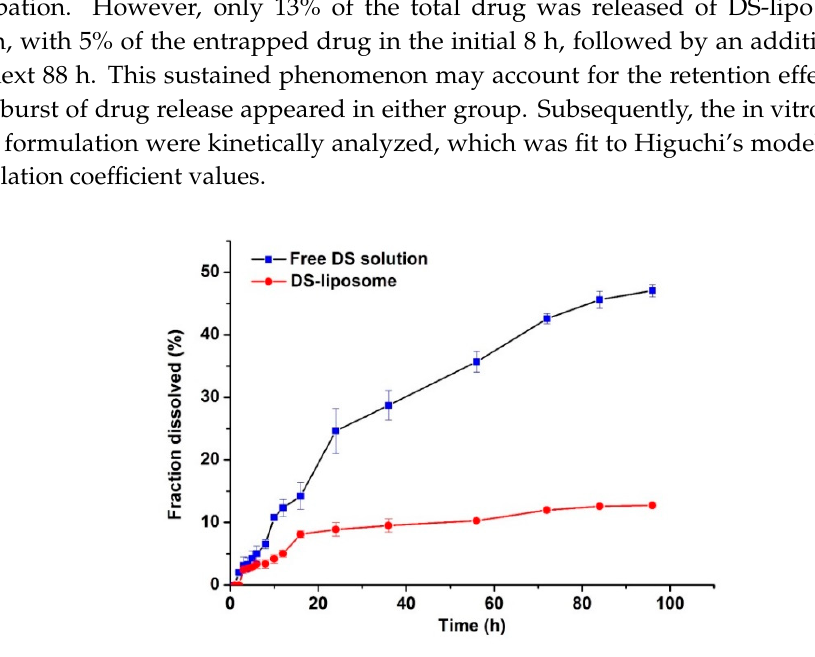
Figure 4. In vitro release of drugs from free DS solution and DS-lipo.